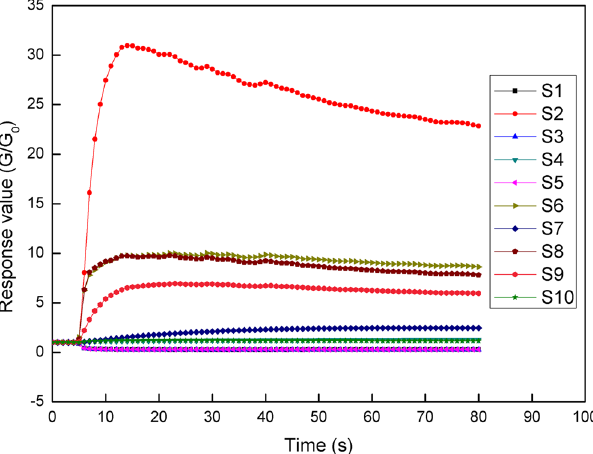
Figure 1. Typical responding curves of liquor samples obtained from electronic nose.